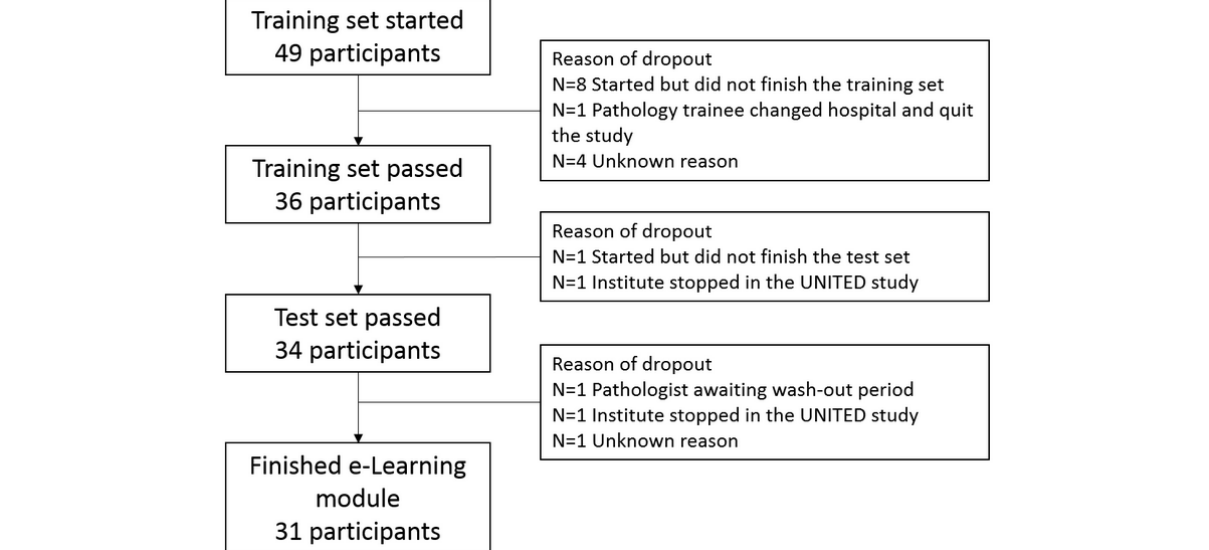
Figure 1. Overview of the number of participants of the e-Learning and the reasons for not finishing the e-Learning cycle.